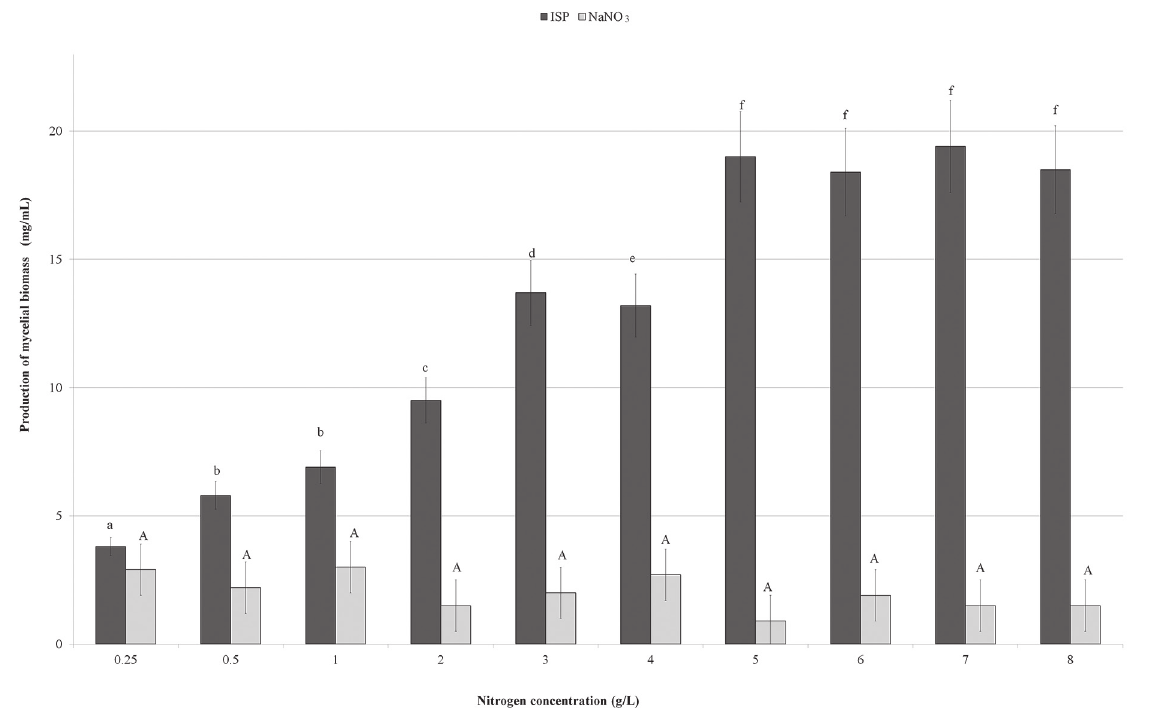
Figure 1 - Mycelial biomass production (mg/mL) of Agaricus subrufescens obtained in minimum liquid Pontecorvo medium at different concentrations (g/L) of isolated soy protein (ISP) and NaNO